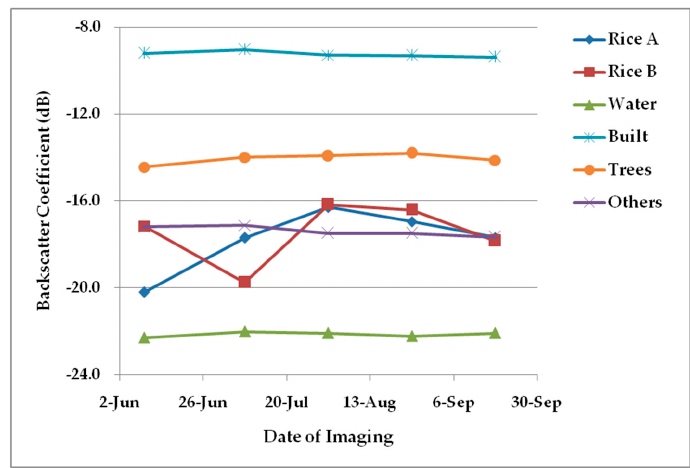
Figure 5. Temporal backscatter profiles of Rice subclasses and the other land-cover at VH polarization. Data points correspond to Sentinel-1A images of Shanghai acquired on 9 June, 8 July, 1 August, 25 August and 18 September in 2015, respectively.